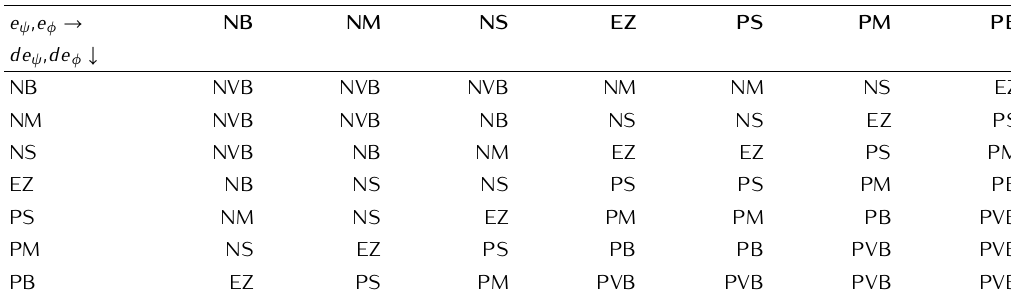
Table 2. Fuzzy rules for type-2